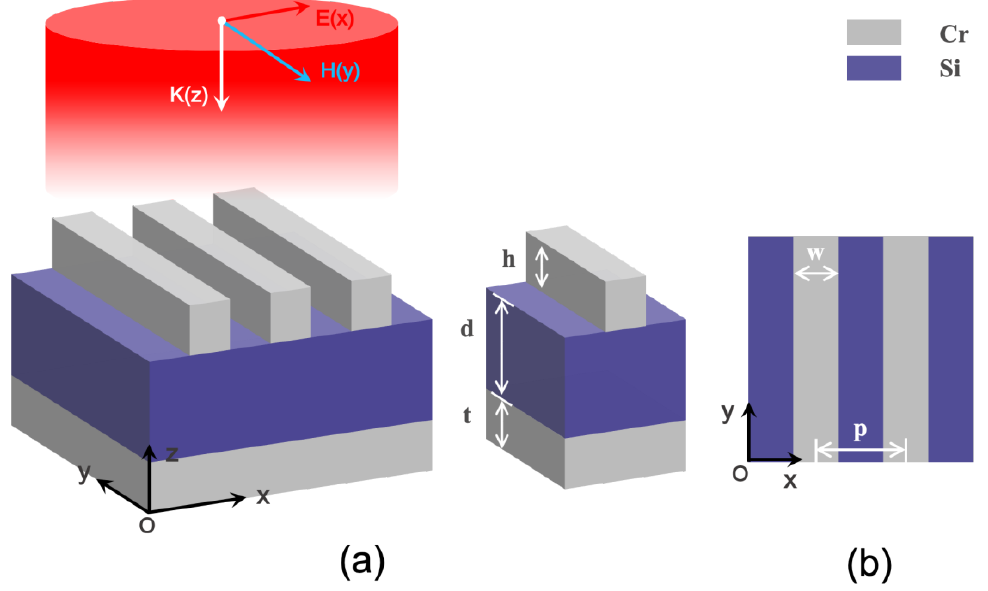
Figure 1. Diagram of metal-insulator-metal (MIM) absorber with p = 800 nm, w = 560 nm, h = 200 nm, d = 400 nm, and t = 22 nm. ( a ) Three-dimensional schematic of the absorber and ( b ) cross-section of the absorber along the x-y plane.